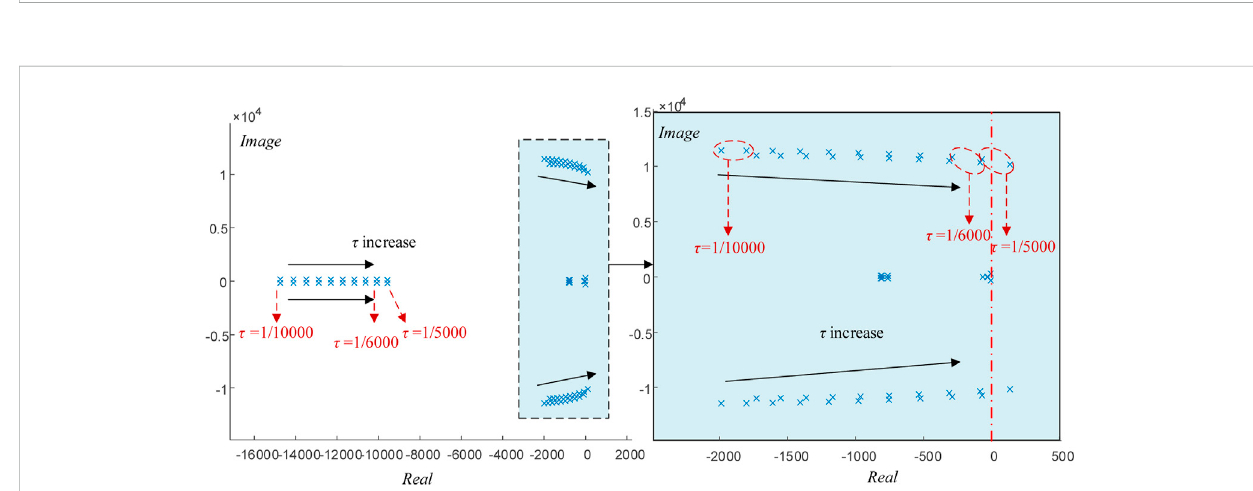
FIGURE 6 The trajectory of the dominant eigenvalues with k varying.